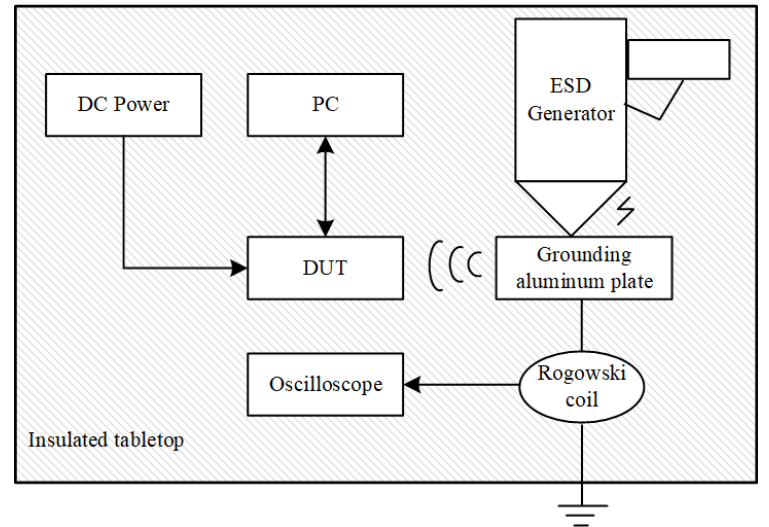
Figure 5. Schematic diagram of space electrostatic discharge test